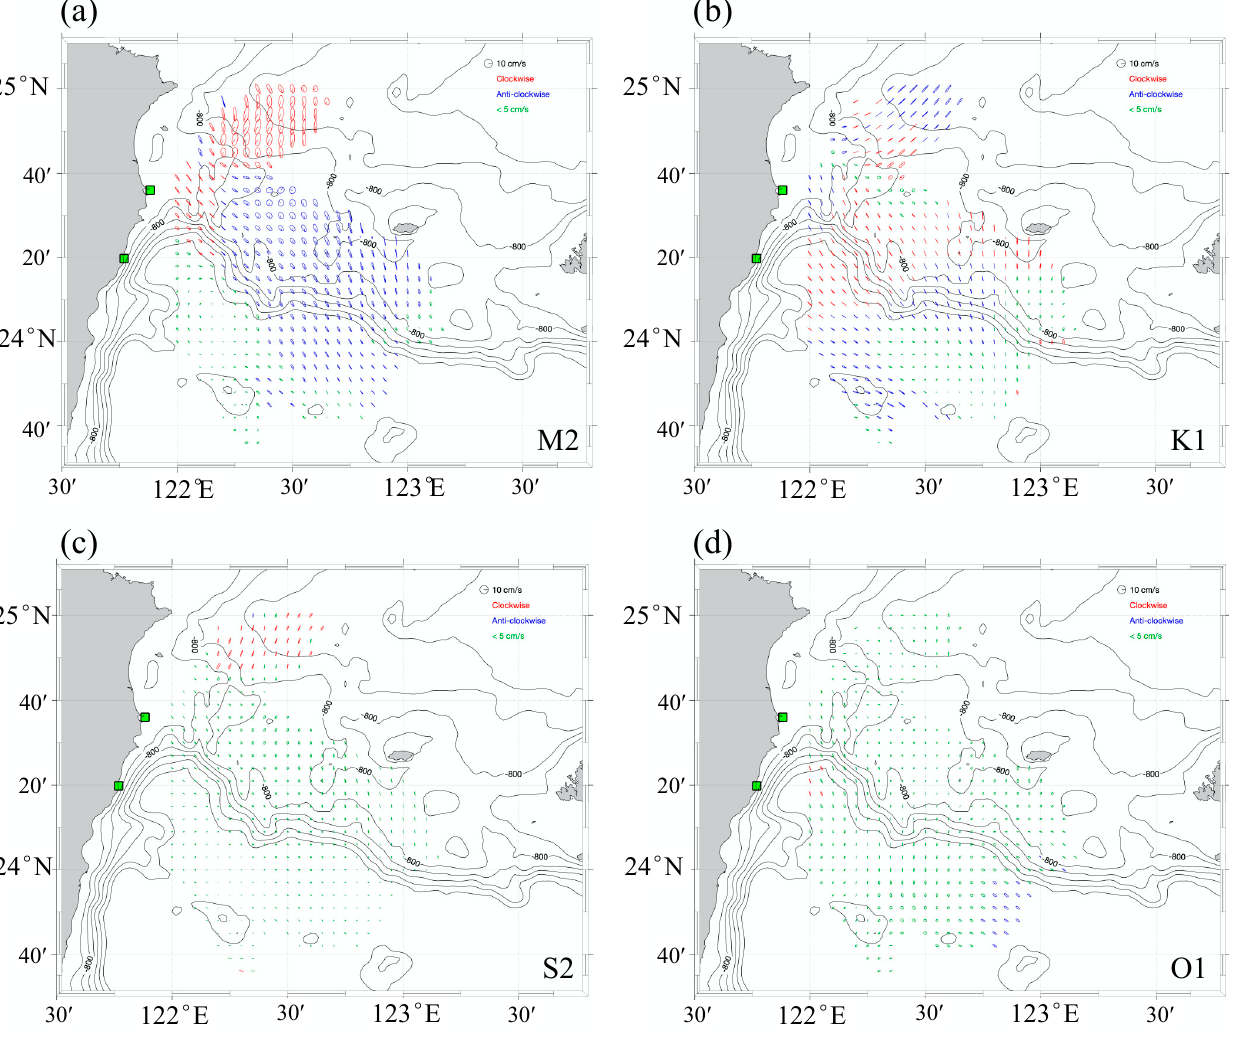
Figure 9. ( a ) M 2 , ( b ) K 1 , ( c ) S 2 , and ( d ) O 1 tidal ellipses derived from harmonic analysis of the HFR current data. The red (blue) ellipses indicate clockwise (anti-clockwise) rotation. The green ellipses indicate tide speeds of less than 5 cm/s. The thick black line is the − 800 m isobath.